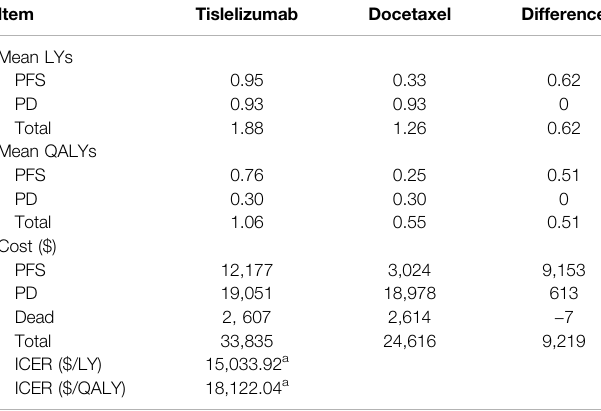
TABLE 2 | Base-case analysis